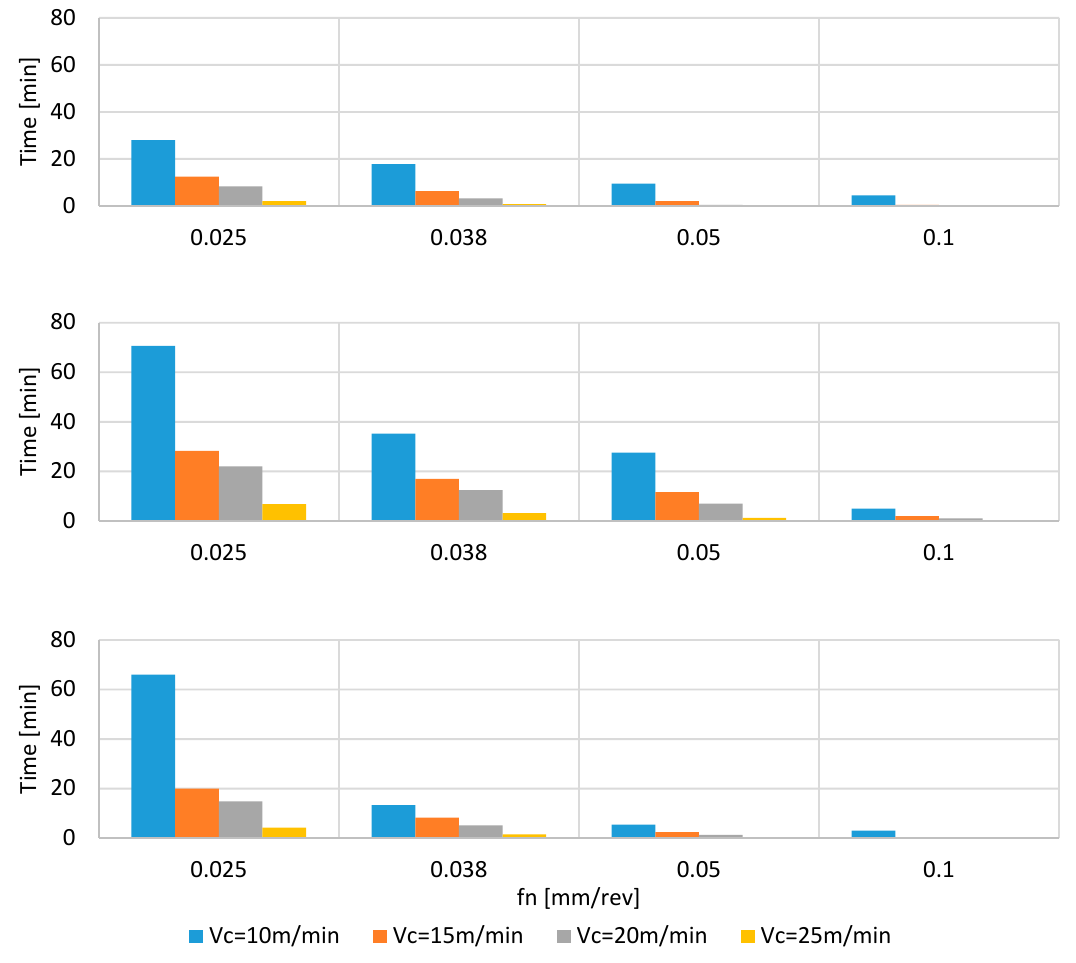
Figure 6. Tool life comparison for drilling of the TNB alloy (up), ingot MoCuSi alloy (middle) and extruded MoCuSi alloy (down).